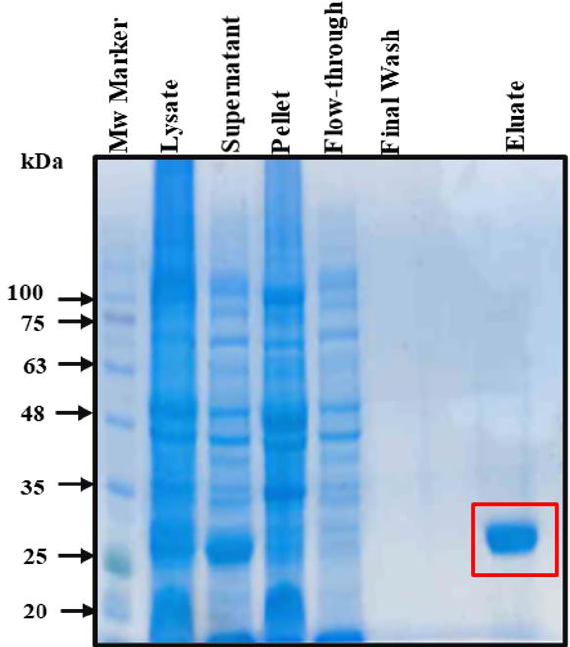
Figure 1. SDS–PAGE analysis of expressed and purified NNAT from K. pneumoniae . Crude lysate of E . coli containing overexpressed KpNNAT was subjected to centrifugation to separate the soluble fraction (supernatant) from the insoluble (pellet). The solubilised fraction was purified by Ni 2+ -IMAC and eluted with 350 mM imidazole. All fractions were analysed on a 12.5% ( w / v ) polyacrylamide gel containing 10% ( w / v ) SDS and visualised with Coomassie brilliant blue staining. The square indicates the purified protein, which is ~27 kDa.